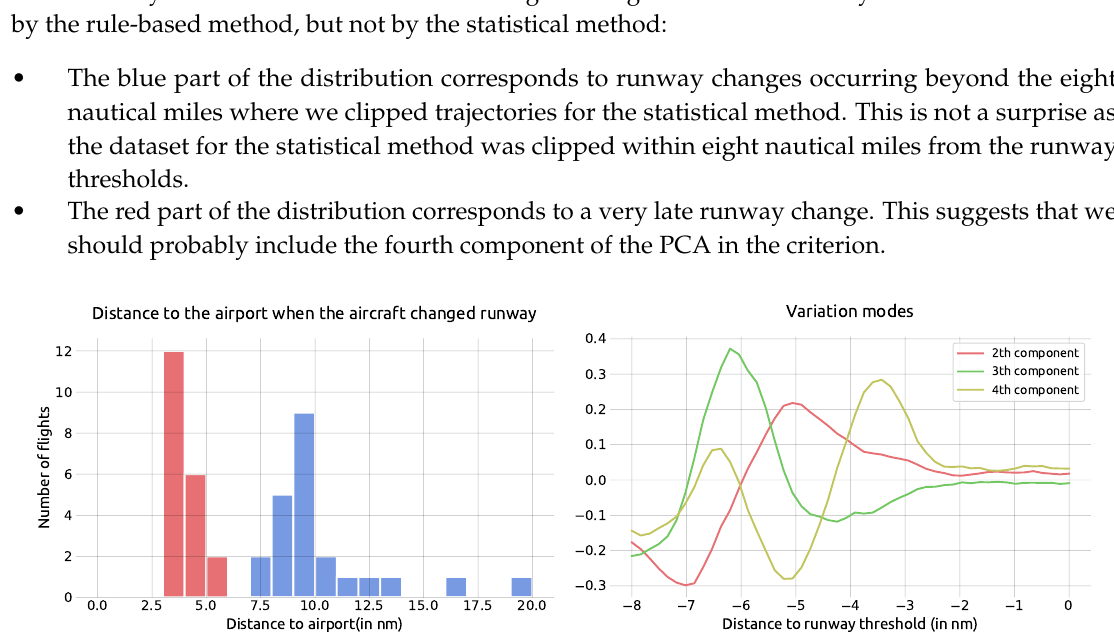
Figure 6. The statistical method did not detect runway changes happening beyond eight nautical miles (out of scope) and within four nautical miles: the statistical model is to be refined, taking the fourth component (i.e., variation mode [4]) of the PCA into account.